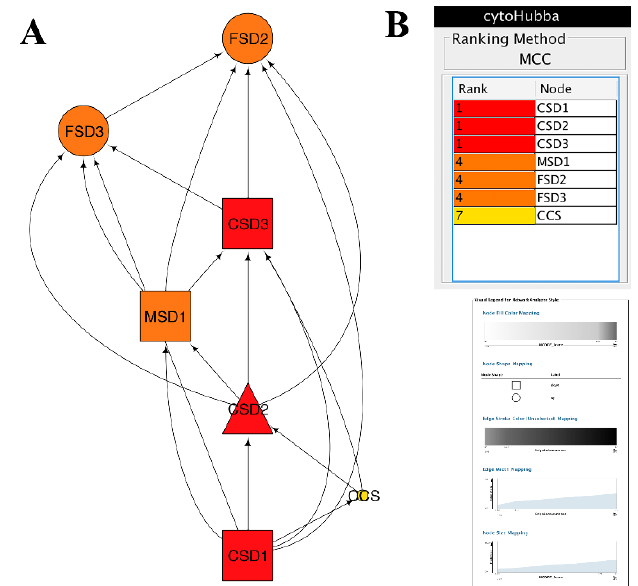
Figure 3. SODs protein–protein interaction PPI sub-networks induced by trypsin were constructed by cytoscape software. Rectangle nodes represented proteins encoded by downregulated genes, while round nodes represented proteins encoded by upregulated genes. The CSD2 without significantly differential expression was represented as triangle-shaped nodes. The nodes were ranked and colored by cytoHubba.